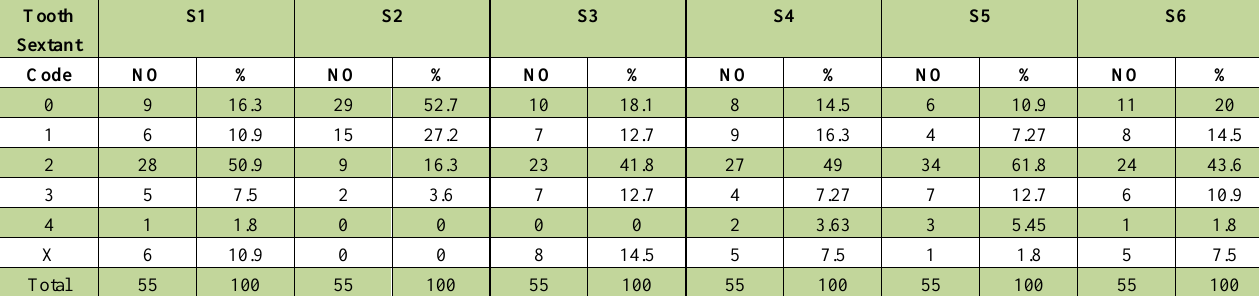
Table 6. Frequency distribution of subjects in terms of CPITN index per